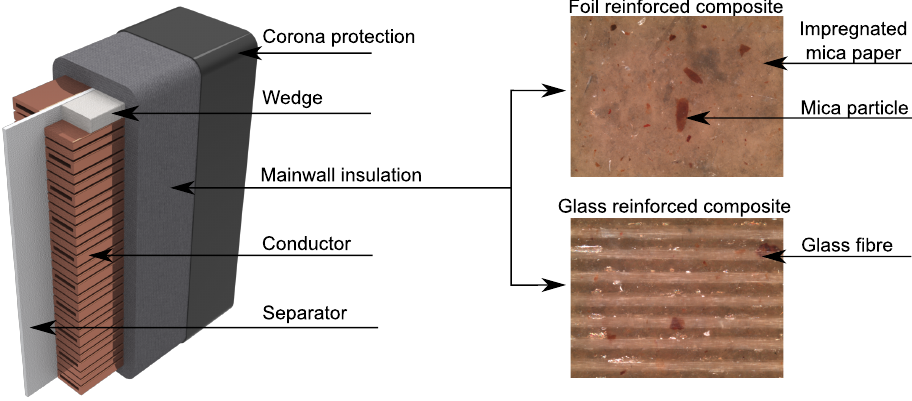
Figure 1. Illustration of stator winding with different structures of mainwall insulation.